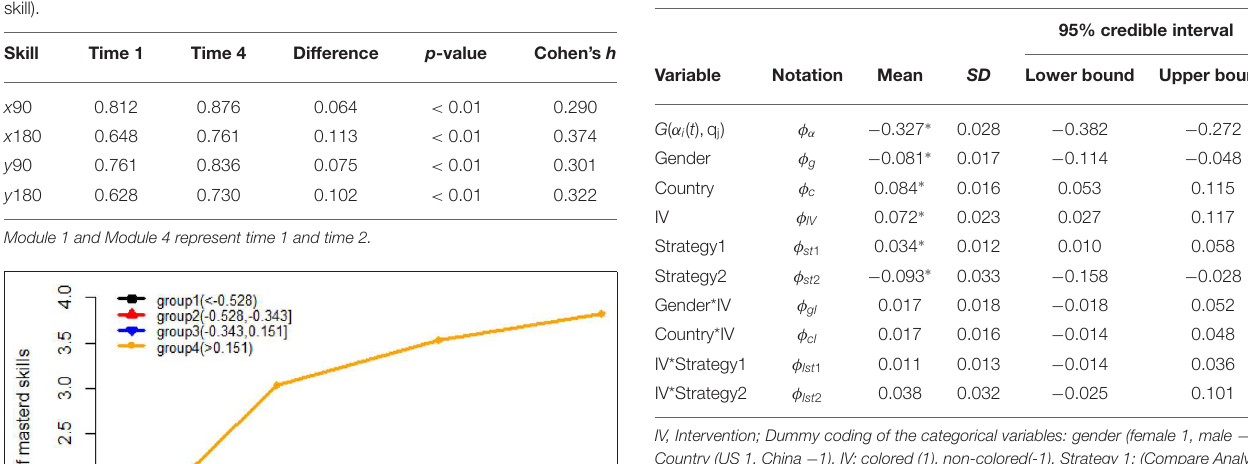
TABLE 9 | The estimated φ s from the response time